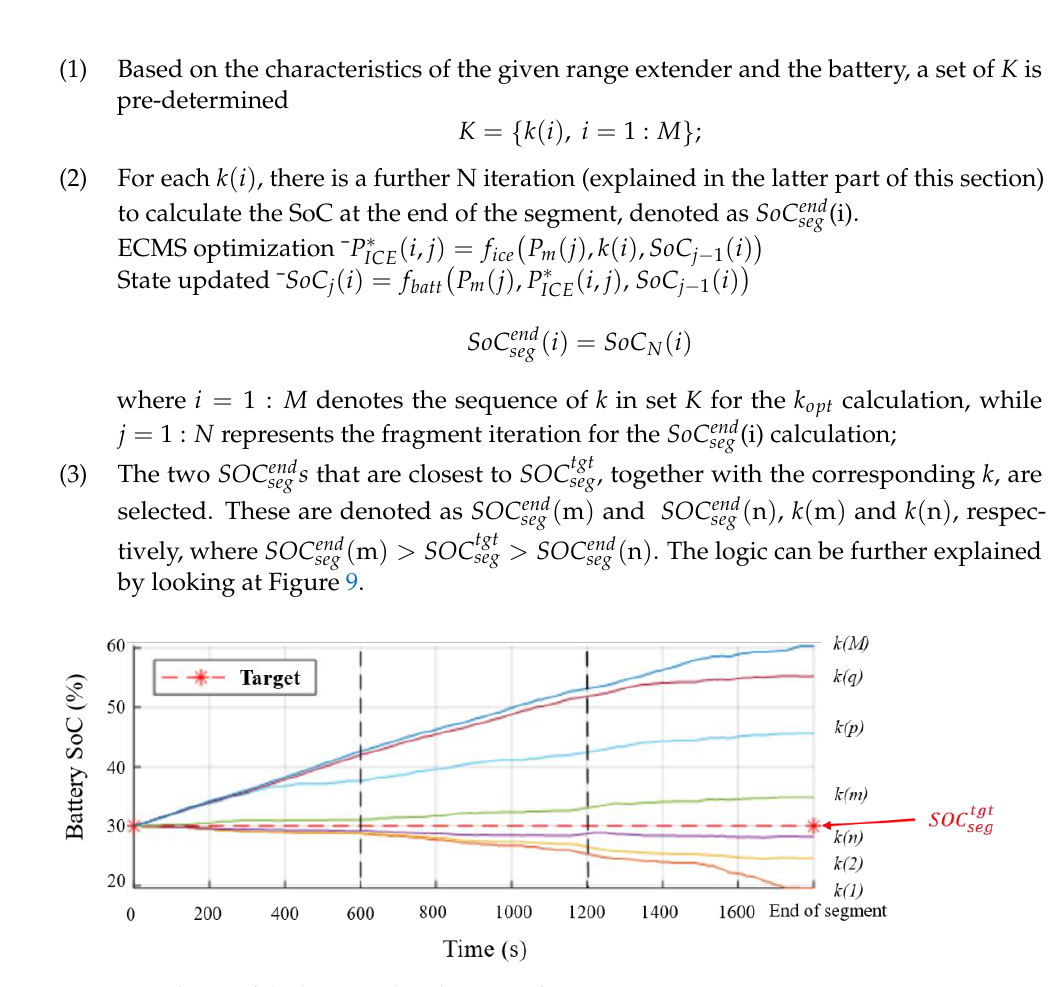
Figure 9. Scheme of the logic used to determine k opt .